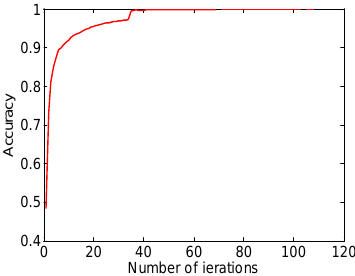
Figure 8. The convergence curve of training accuracy with training iterations.